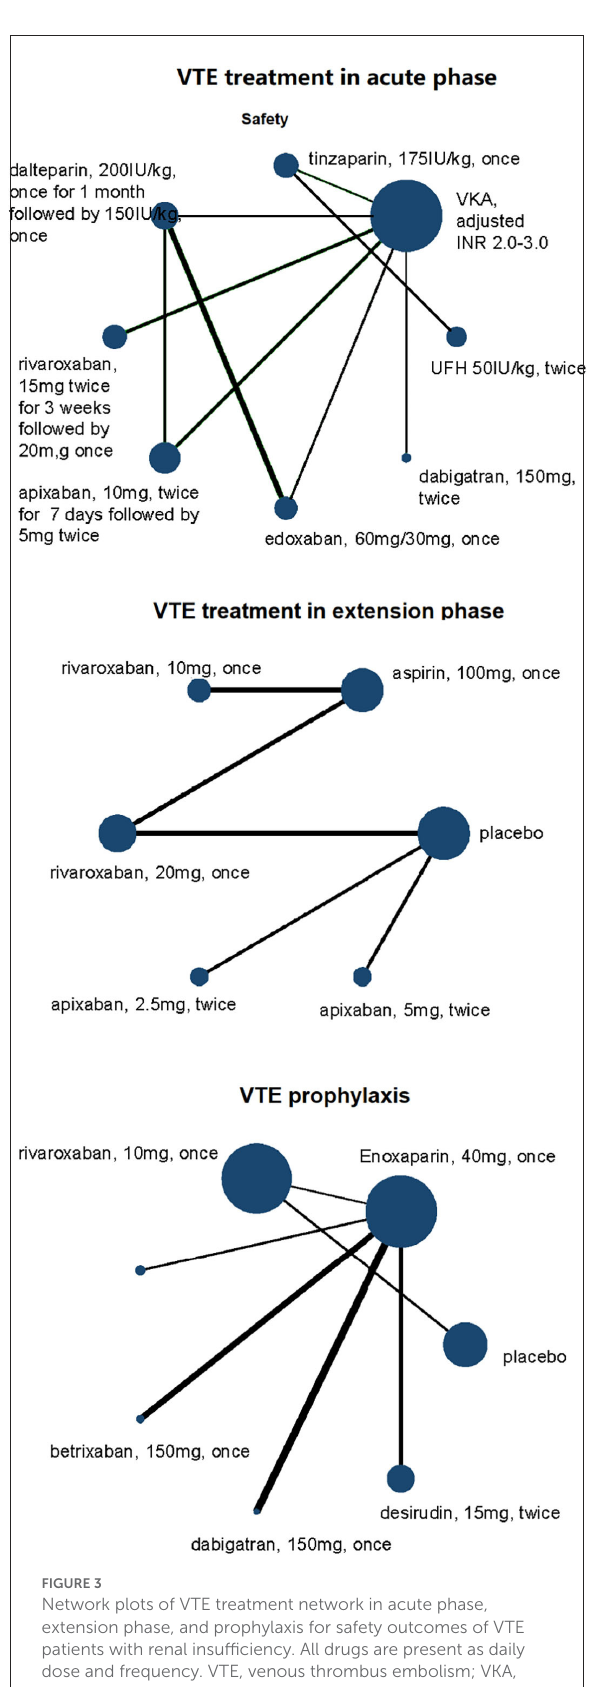
FIGURE3 Network plots of VTE treatment network in acute phase, extension phase, and prophylaxis for safety outcomes of VTE patients with renal insufficiency. All drugs are present as daily dose and frequency. VTE, venous thrombus embolism; VKA, vitamin K